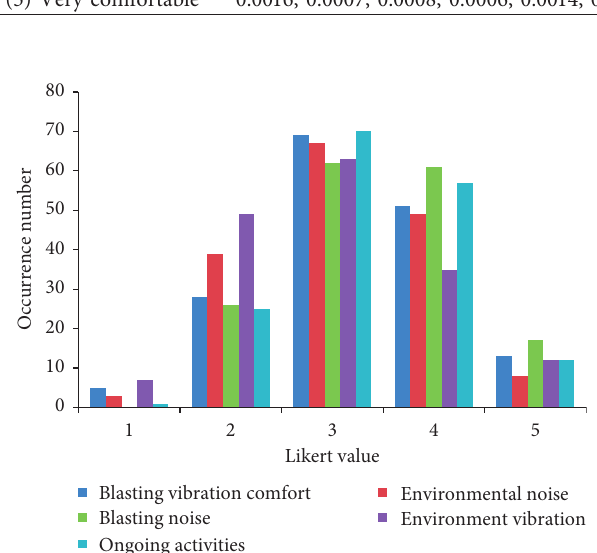
Figure 1: Survey results of 166 groups of data.